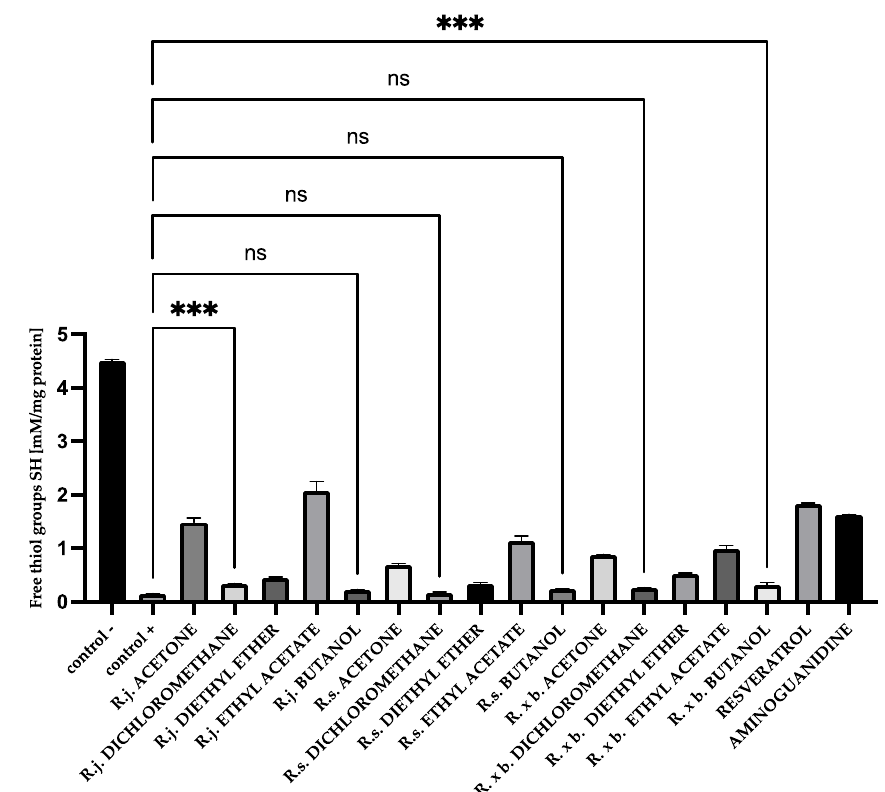
Figure 9. The effect of extracts and fractions on the in vitro formation of SH groups in HSA glycation. R.j., R.s., and R. × b. mean Reynoutria japonica , Reynoutria sachalinensis , and Reynoutria × bohemica , respectively. Error bars shown in this figure are means ± SD for n ≥ 5. *** Statistically significant at p ≤ 0.001 compared to control; ns—not statistically significant at p ≤ 0.05. All other results are statistically significant at p ≤ 0.0001 compared to control +. Detailed information can be found in the Supplementary Material.